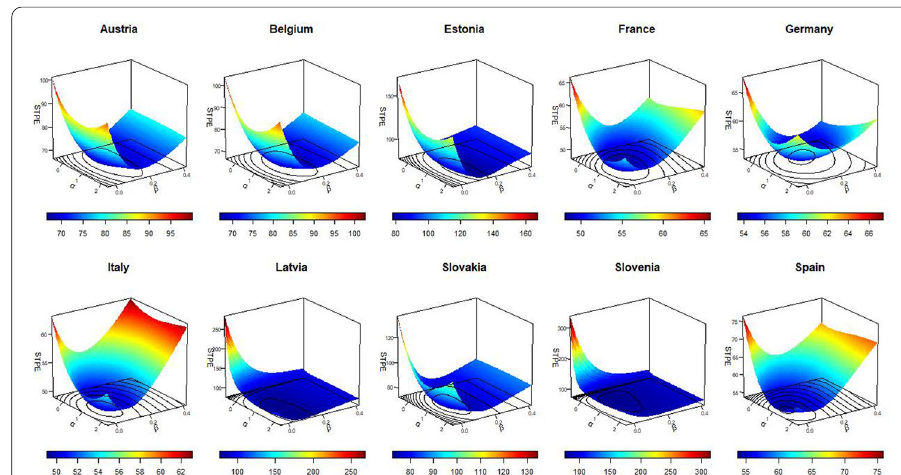
Fig. 3 Estimating 2D‑LQ for ten EA‑19 countries in 2010